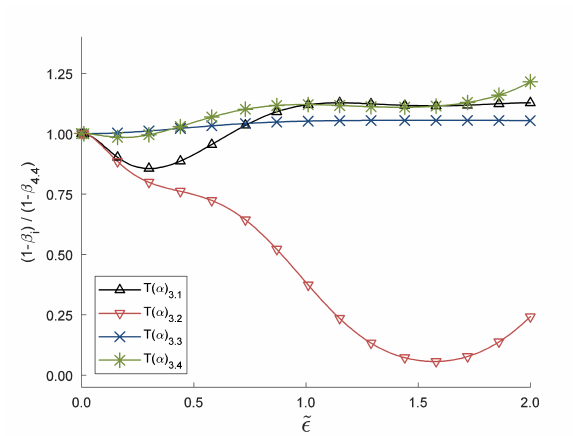
Figure 7: Same as Fig. 6, solid curves only, but larger range of ˜ ϵ